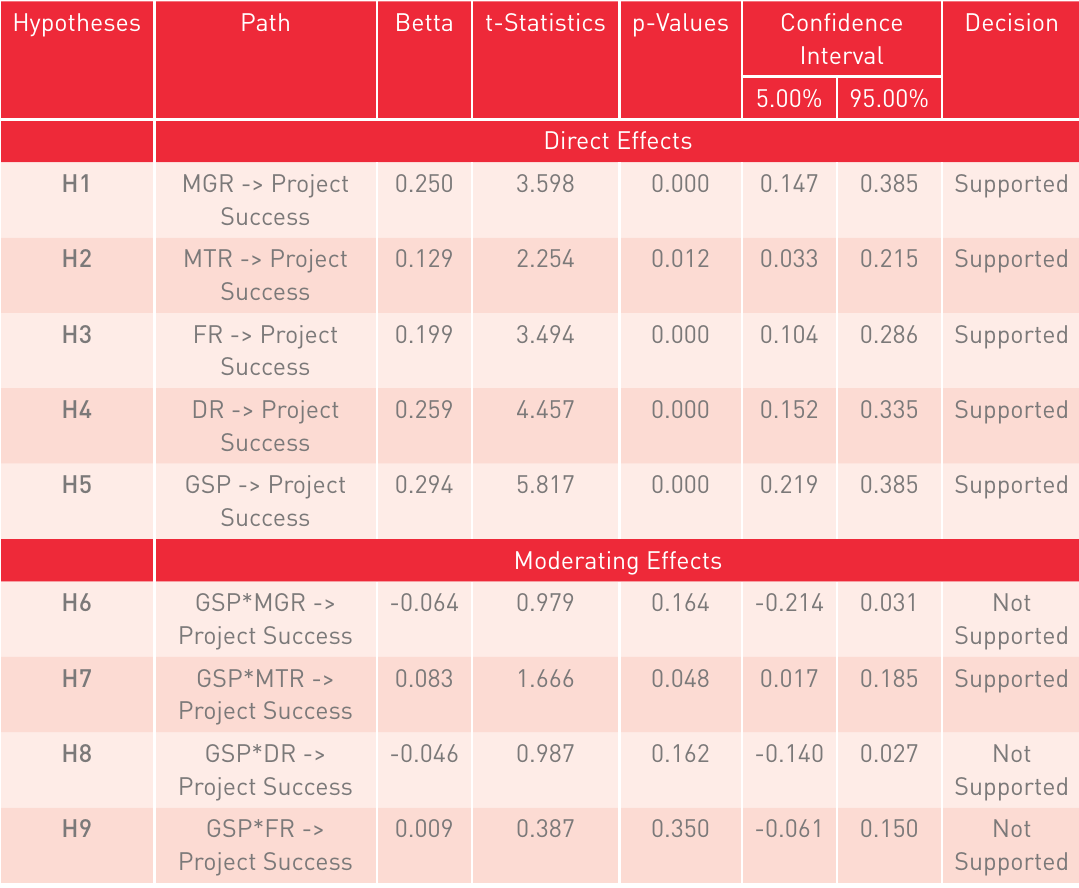
Structural Model Results with Moderating